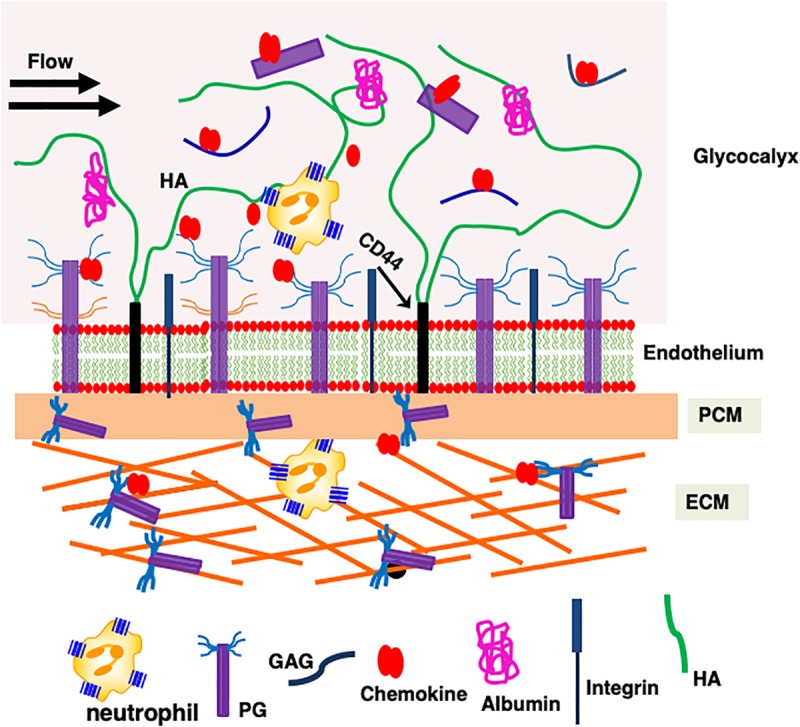
A schematic showing how proteoglycan interactions regulate chemokine-mediated neutrophil trafficking. Endothelial glycocalyx consists of a number of secreted PGs and various proteins such as albumin that functions as a barrier between blood flow and the endothelium. Critical components of the endothelium and glycocalyx are labeled. This figure is not drawn to scale, and its purpose is to illustrate different anatomical regions that are involved in chemokine-mediated neutrophil recruitment to the insult site.